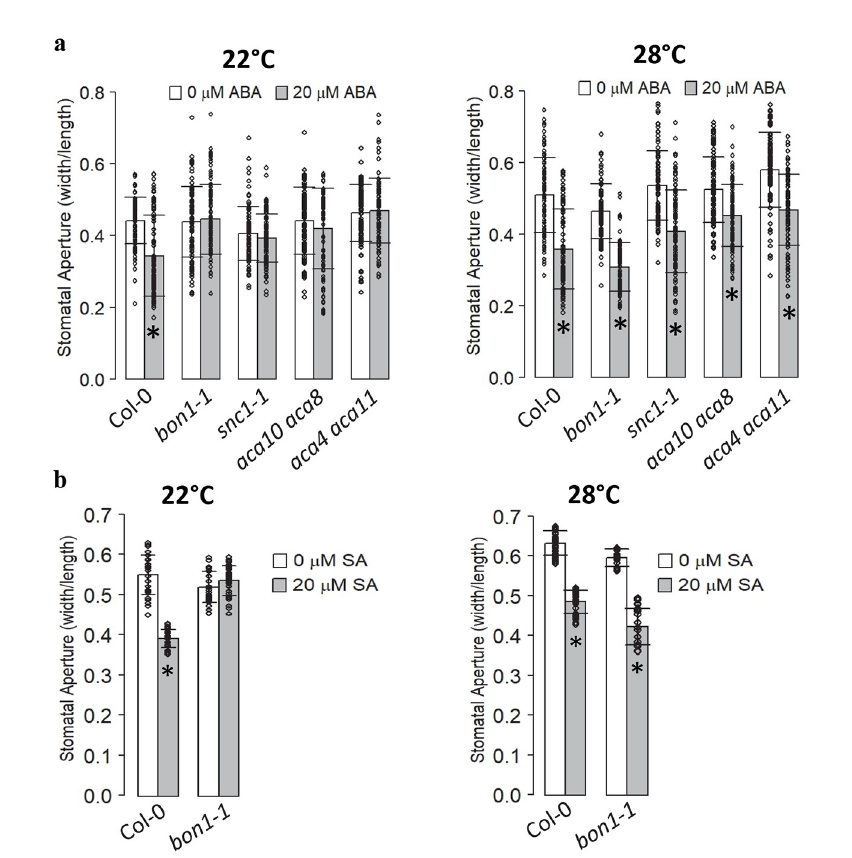
Fig 3. Autoimmune mutants exhibit a temperature-dependent stomatal closure defect in response to ABA and SA. Shown are stomatal apertures in response to 20 μ M ABA ( a ) or SA ( b ) at 22˚C and 28˚C after 1.5 hr incubation. Biological triplicates ( a , n = 90 stomata) or duplicates ( b , n = 60 stomata) were averaged and statistically analyzed with Student’s t test. Asterisks indicate statistically significant differences in stomata aperture between control and treatment ( p < 0.001). Error bars indicate